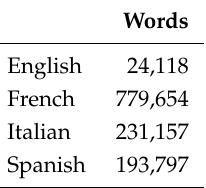
Table 5. Statistics of the crawled corpora used for in-domain language model